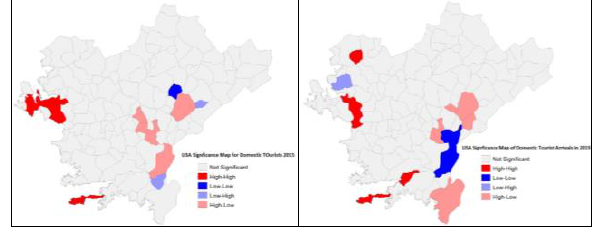
Figure 2. The Moran’s significance maps for domestic tourist arrivals (2015 and